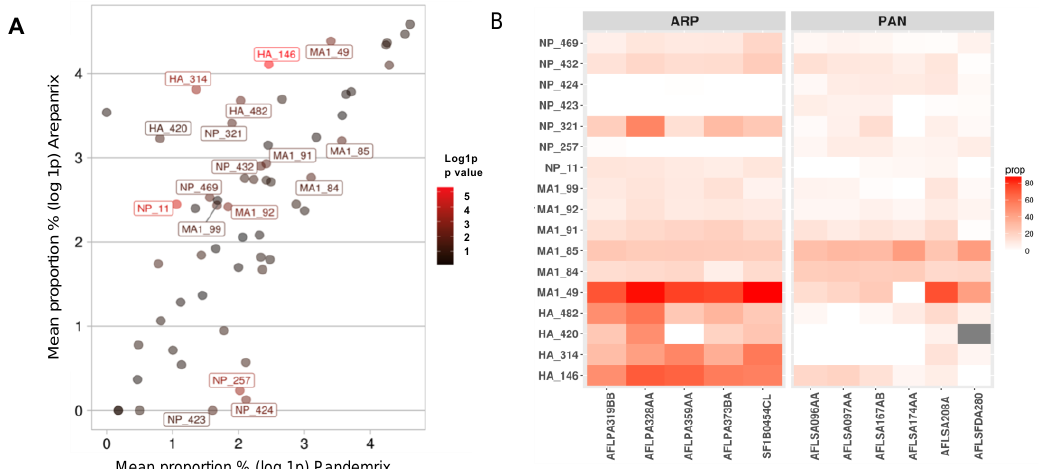
Figure 2. Mean mutation proportion in Arepanrix versus Pandemrix. ( A ) Each data point represents a specific mutated amino acid. This scatterplot maps the log-transformed mean mutation proportion in Pandemrix on the x-axis against log-transformed mean mutation proportion in Arepanrix on the y-axis. Calculated from a two-tailed Student’s t-test; the p -value of each data point indicates how significantly di ff erent the mutation is between vaccines. As data points are colored based on their p -value, the redder on the gradient scale, the more significant the mutation is in regard to di ff erentiating Pandemrix and Arepanrix. ( B ) The heatmap is indicating the actual mutational proportion with the y-axis showing the mutated positions and the x-axis showing the vaccine